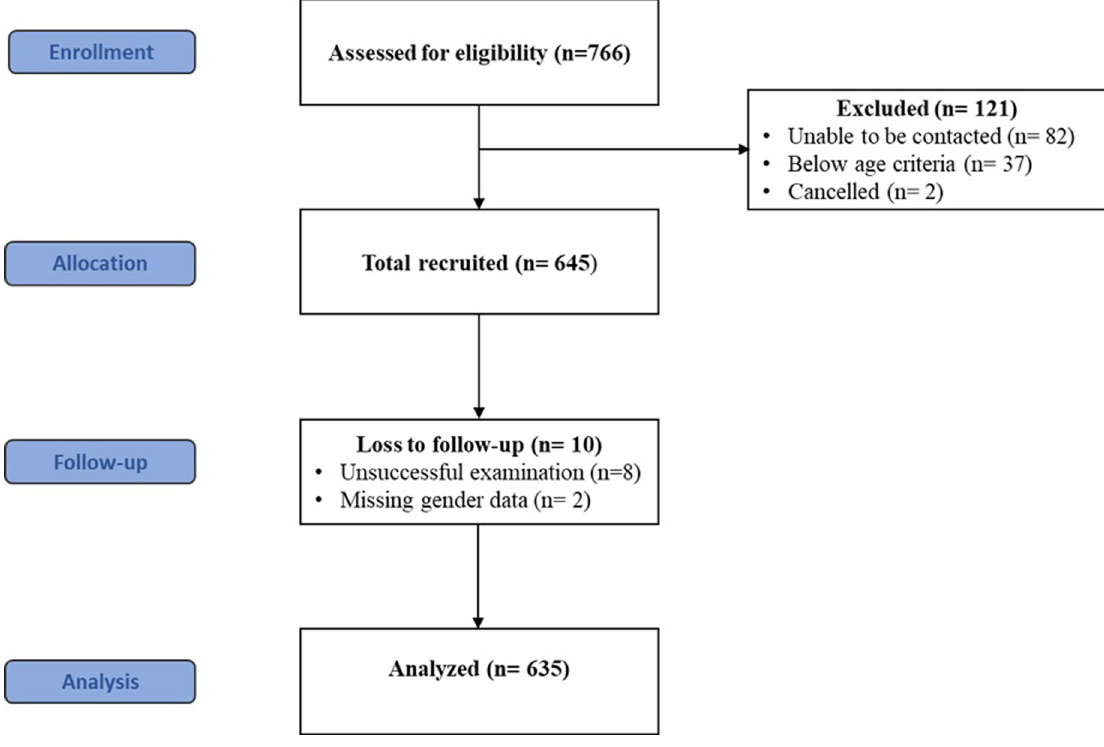
Fig 1. CONSORT flow